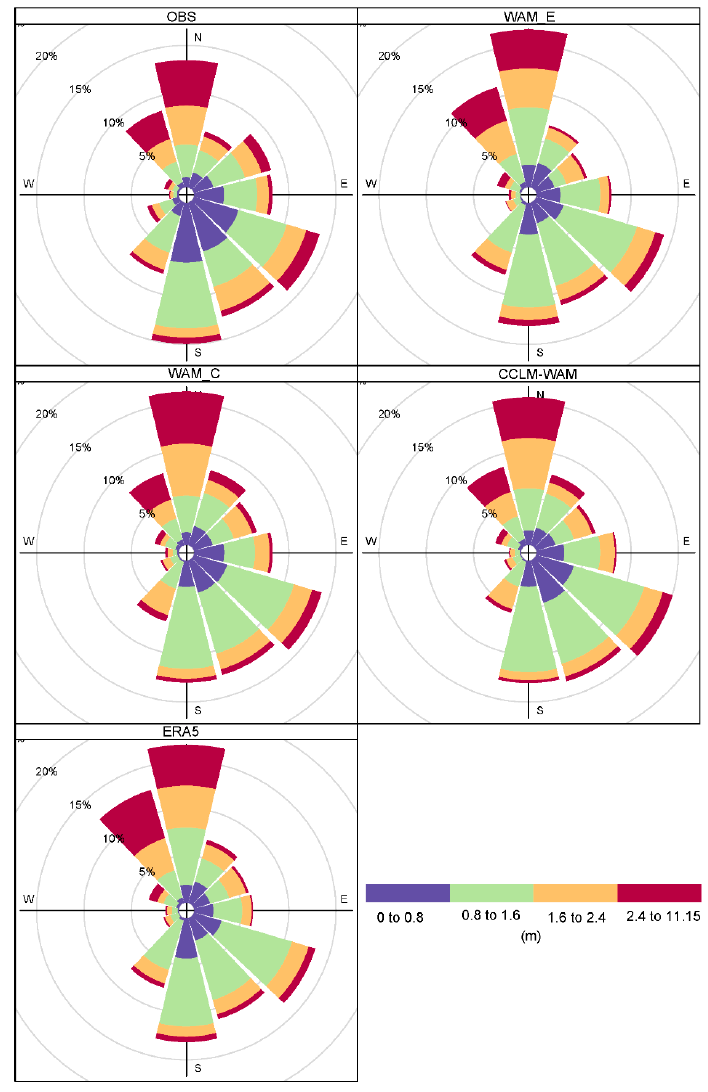
Figure 6. The same as Figure 4 but for the mean wave direction at station IEODO.